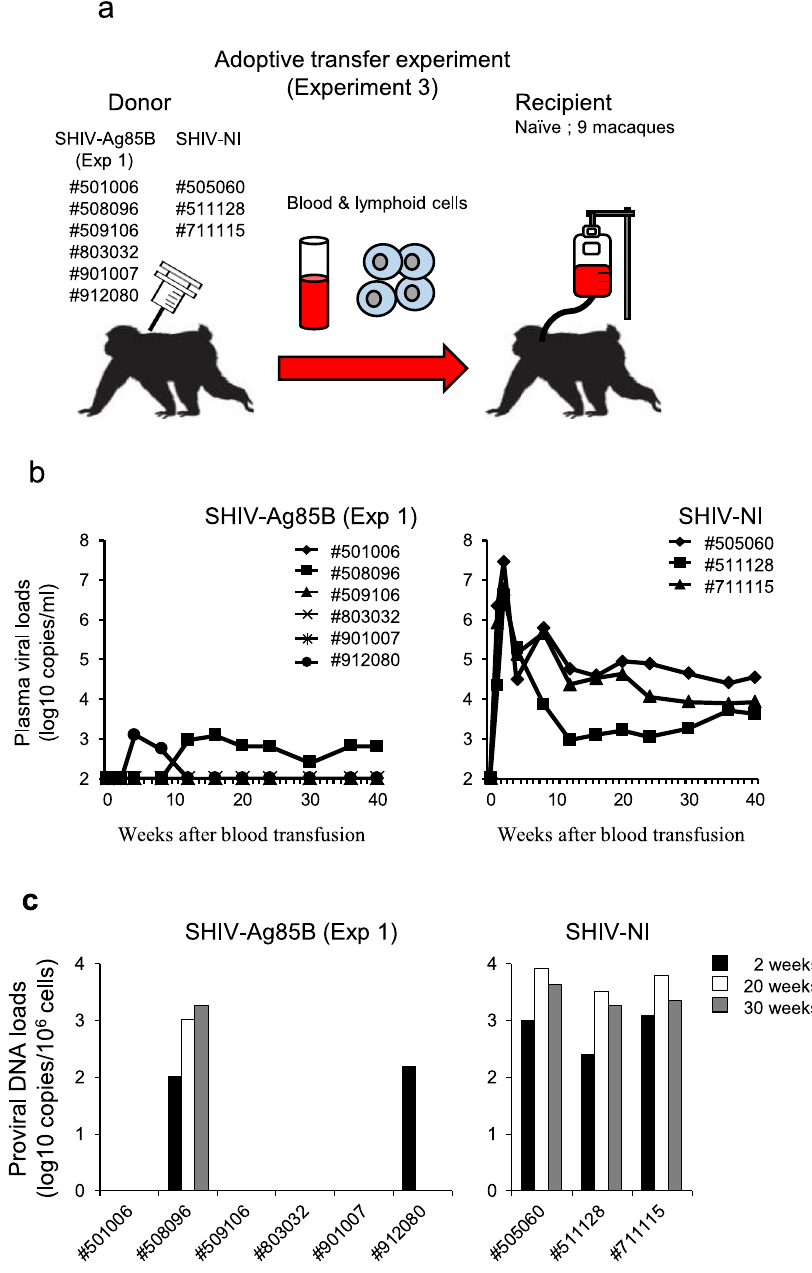
Fig. 9 Kinetics of viral loads and proviral DNA after adoptive transfer. a Schematic of the adoptive transfer experiment (Experiment 3). b Plasma viral loads following adoptive transfer are shown. Plasma viral loads were measured by quantitative RT-PCR. The detection limit of plasma viral load was 100 copies/ml. c Proviral DNA loads in PBMCs following adoptive transfer are shown. Proviral DNA loads were measured by ultrasensitive digital PCR. The detection limit of proviral DNA load was 5 copies per 10 6